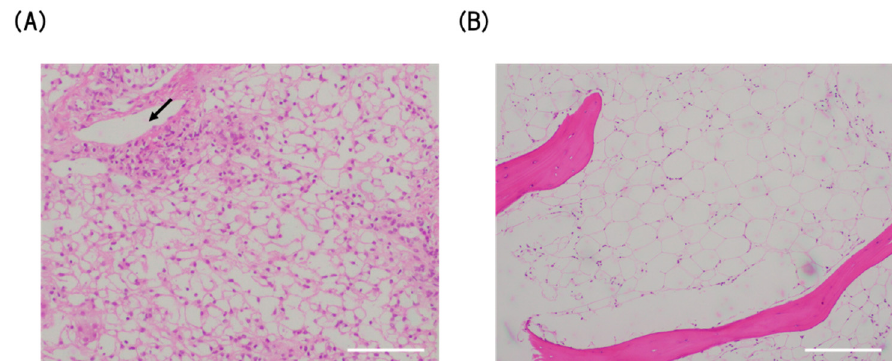
Figure 1. (A) Liver biopsy showed periportal zonal necrosis with macrovesicular steatosis compatible with the diagnosis of acute hepatitis (H-E (hematoxylin and eosin) staining, ×10). Arrow indicates portal vein. (B) Bone marrow biopsy showed decreased hematopoietic cells (hypocellular marrow), with increased adipose tissue consistent with the diagnosis of aplastic anemia (H-E staining, ×10). Scale bar, 500 µm.